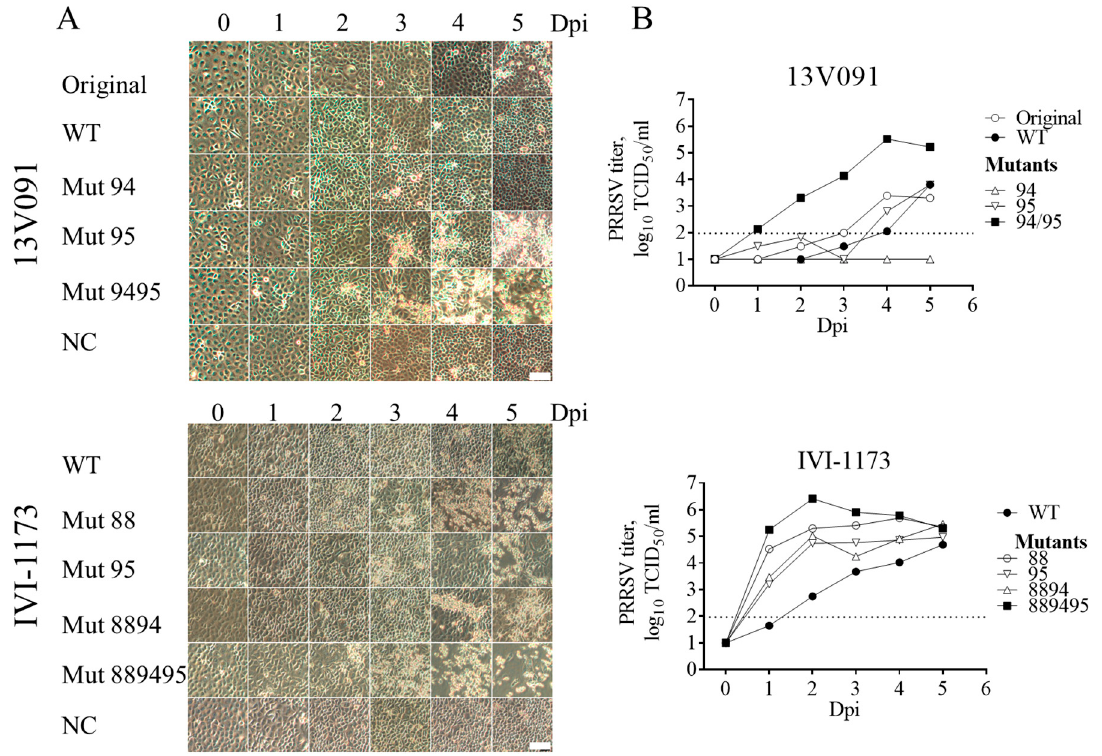
Figure 4. ( A ) CPE in MARC-145 cells at 0–5 days post inoculation with the original 13V091 or rescued virus from the infectious clones (WT) and mutants of strains 13V091 and IVI-1173. Scale bar = 100 µ m ( B ) Virus replication kinetics in MARC-145 cells. The dotted line represents the limit of detection for the assay.